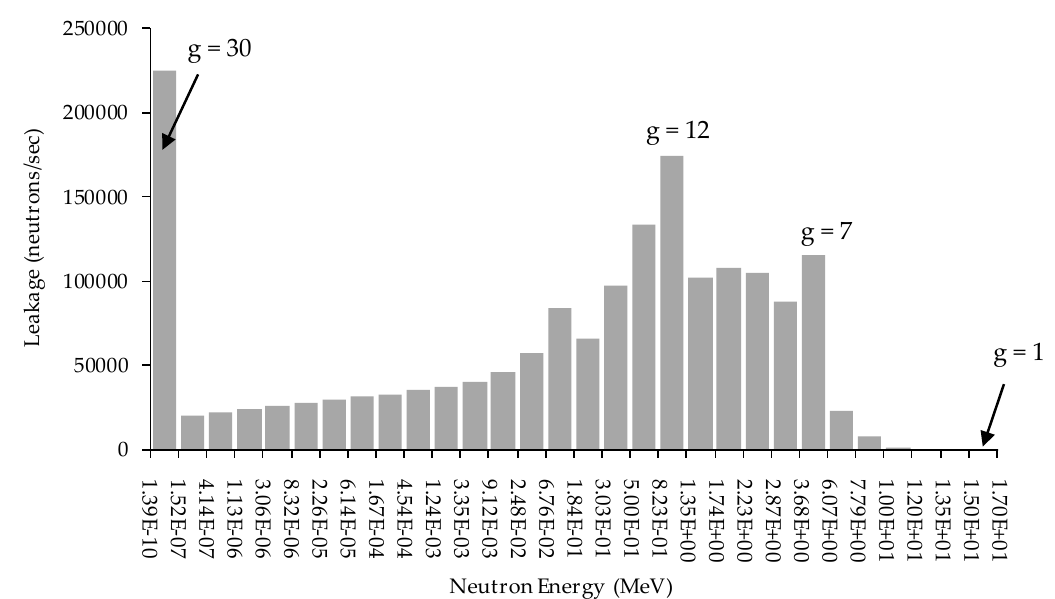
Figure 1. Histogram plot of the leakage for each energy group for the PERP benchmark. Table 2. Summary of integrals of neutrons for the PERP benchmark.